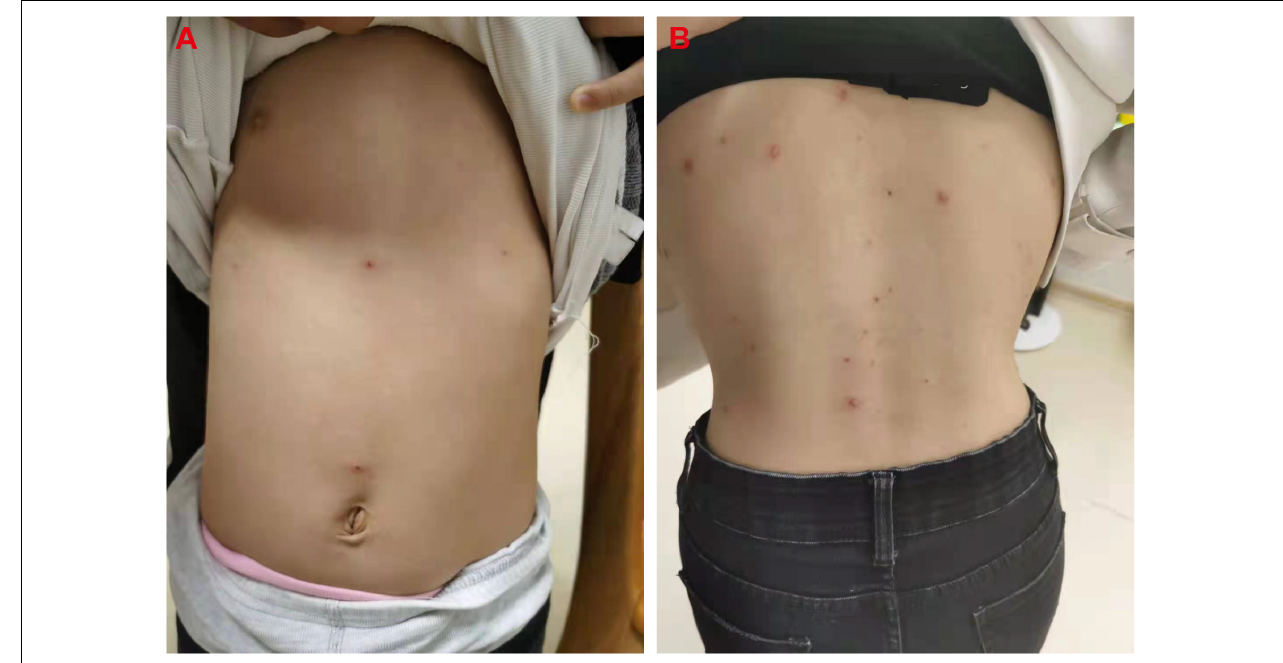
FIGURE 3 | Rash in the girl (case 2, A ) and the mother (case 3, B